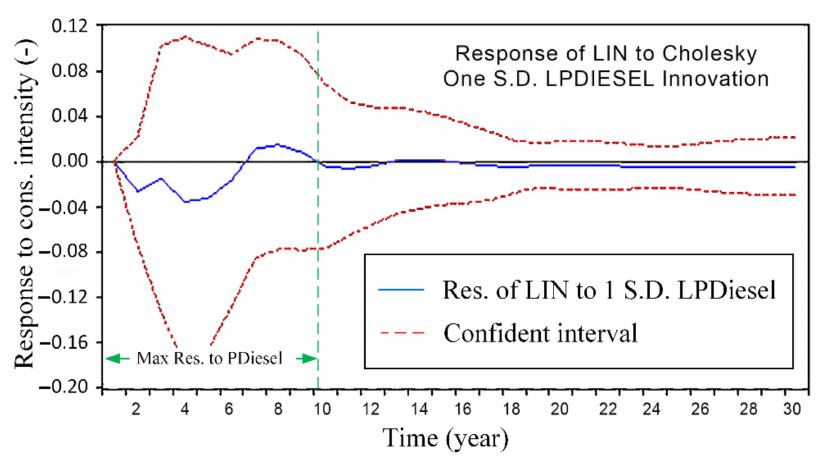
Figure 2. The estimated effect of a diesel price impulse on the rate of a standard deviation due to the energy consumption intensity, between 2020–2050.